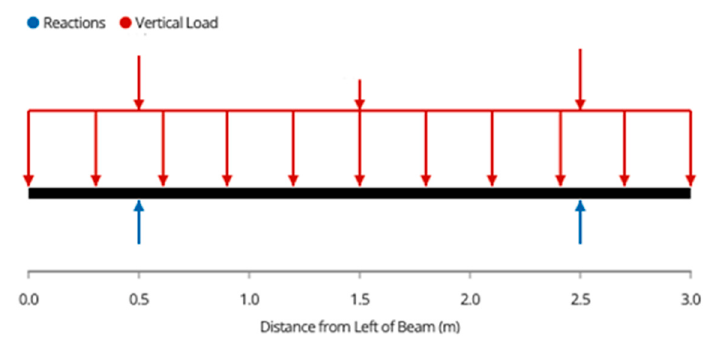
Figure A13. Bottom beam free force diagram. The shear force diagram is shown in Figure A14.